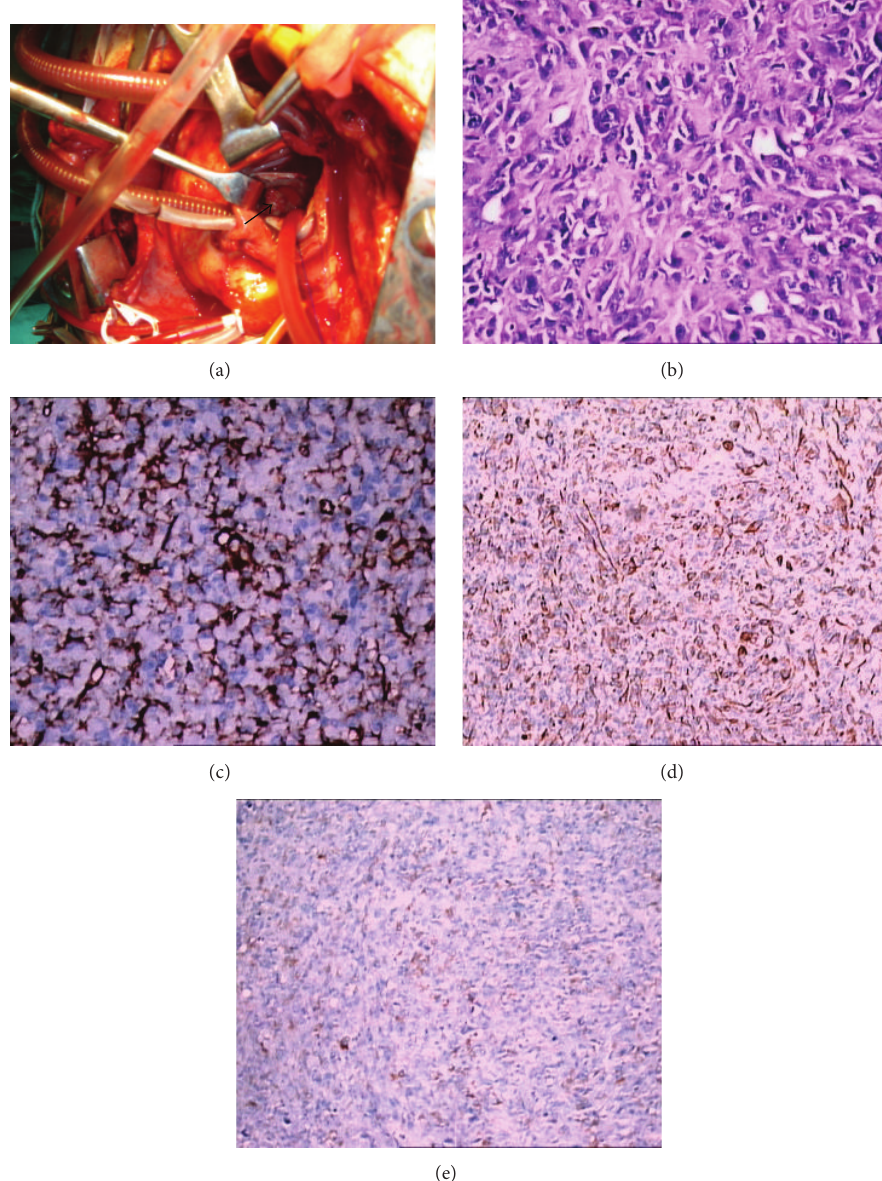
Figure 2: Intraoperative situs with view through the intra-atrial septum (transseptal approach). The arrow marks the roughly 1cm large tumour originating at the posterior leaflet of the mitral valve (a). Haematoxylin and Eosin stain displaying a tumour consisting of irregular neoplastic vascular channels surrounded by atypical spindle shaped and epithelioid tumour cells ( × 40) (b). In immunohistochemical staining the tumour cells are stained with CD31 ( × 40) (c) and focally with Pan CK ( × 20) (d) and S-100 ( × 20) (e). The cells are pleomorphic and